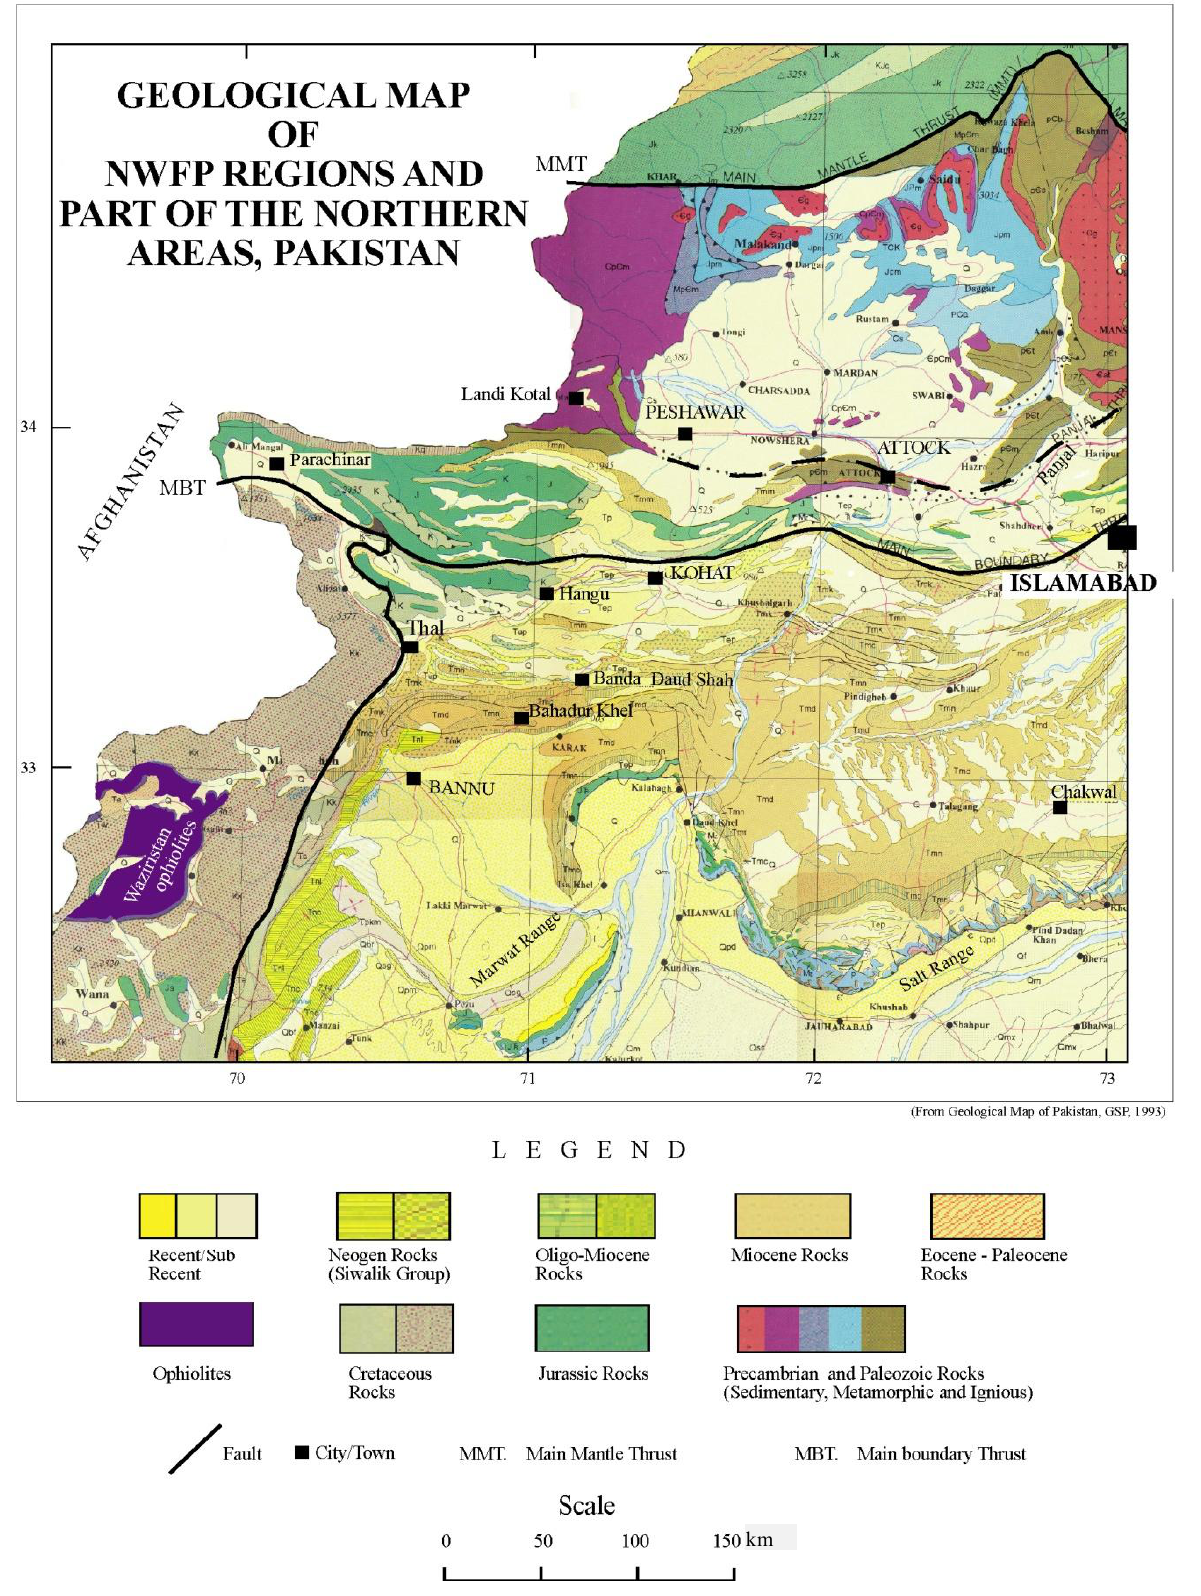
Figure A4. Generalized geological map of North Waziristan, Bannu, Kohat, Islamabad and northern part of Pakistan (adapted from Geological Map of Pakistan